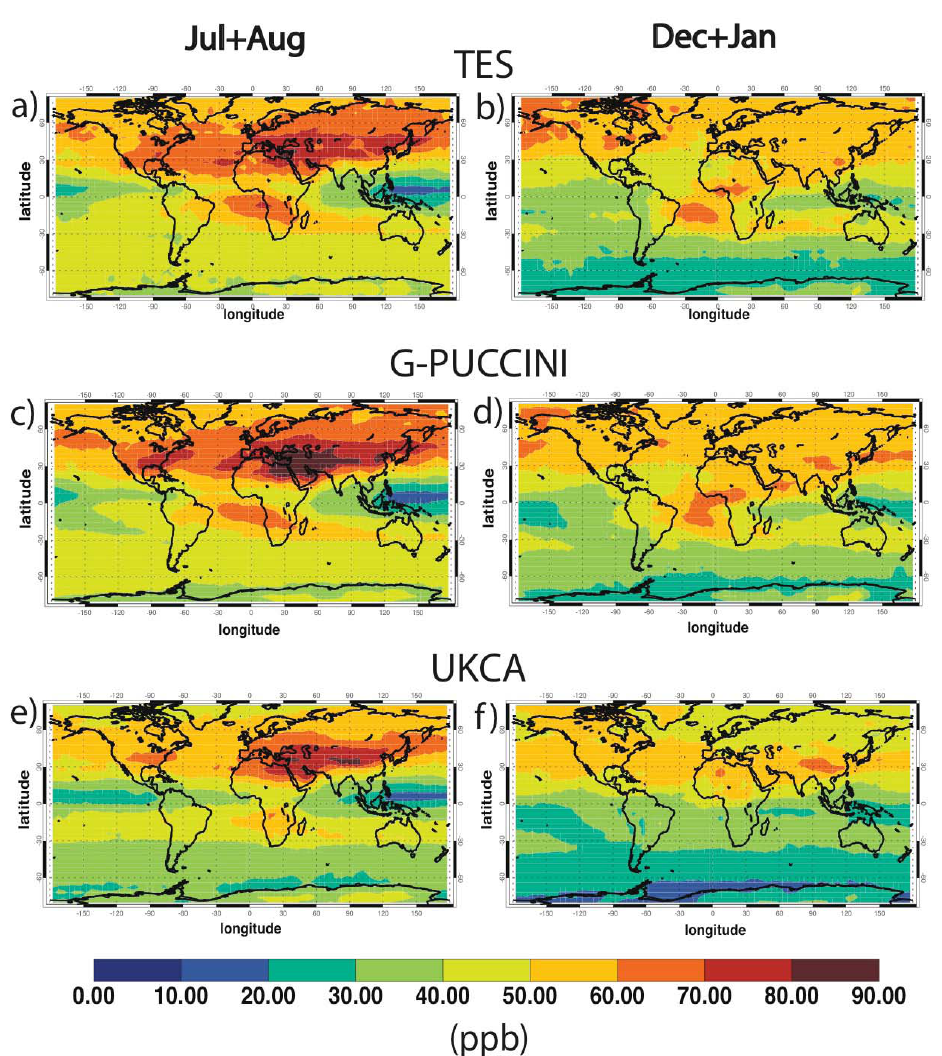
Fig. 2. Mean 2005–08 middle/lower free tropospheric O 3 concentrations for TES (a, b) , G-PUCCINI (c, d) and UKCA (e, f) in July–August (left panels) and December–January (right panels). We used data from 7 TES pressure levels between 800 and 400hPa. TES sampling and operators kernels have been applied to the model output. The data have been smoothed by averaging on a 4 × 5 degree